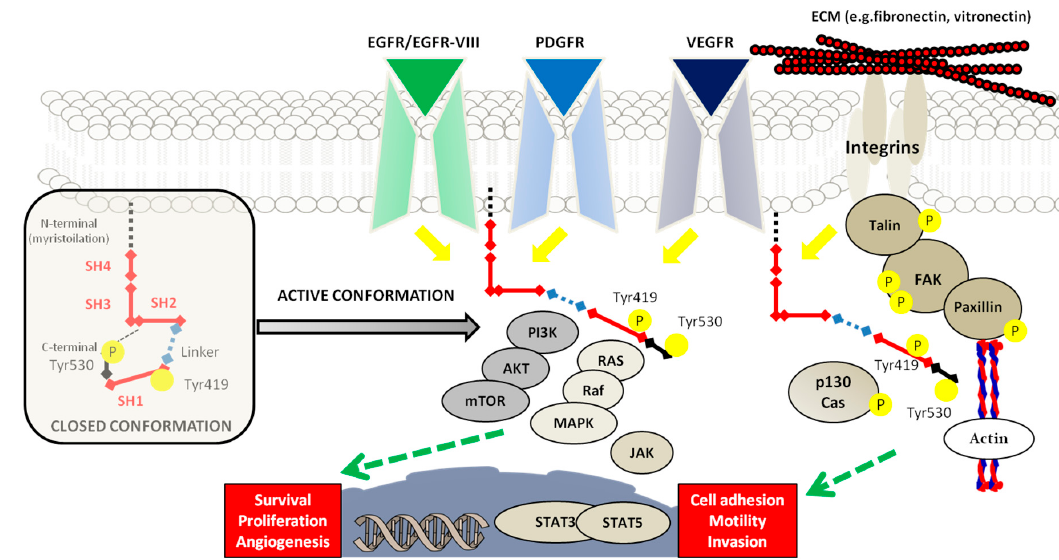
Figure 2. Schematic representation of SRC structure and regulation. The inactive form of SRC is illustrated on the left side, with the specification of each SH domain; in this closed conformation, the phosphorylation of Tyr530 on C-terminal creates a link with the SH2 and the catalytic site, which is positioned on SH1, becoming not accessible for the substrates. In the transition to the active form, the phosphorylation of Tyr419 is showed with the main pathways that act by downstream and upstream effectors. The conformational switch is mediated by many phosphatases, such as PTP α , PTP γ , SHP-1 and -2, and PTP1B, able to dephosphorylate SRC. The regulation of activated SRC is displayed with the RTKs and integrins signaling. In particular, the downstream effectors of RTKs/SRC interaction lead to target genes transcription for survival, proliferation, and angiogenesis sustainment. The interaction of integrins with ECM components and their localization on cell adhesion sites, determines the modulation of cell motility: The SRC signaling pathway induces a cascade that results in the phosphorylation of several proteins, such as FAK, talin, and paxillin, with the final actin cytoskeleton regulation that is responsible for migration and invasion mechanisms.